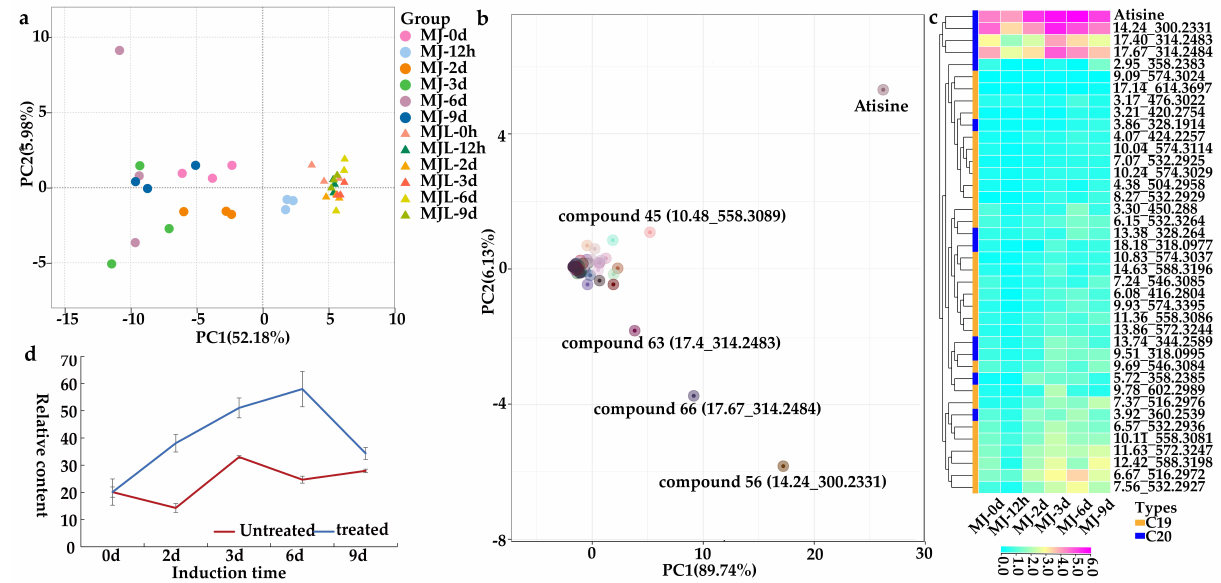
Figure 1. The production of Das is a major metabolic response of A. gymnandrum sterile seedlings to induction. MJ and MJL refer to the sample of root and aerial portions. ( a ) Principal component analysis of A. gymnandrum of different plant portions shows compounds with peak accumulation occurring at the indicated time, demonstrating that MJ has a greater impact on the root than aerial portions. ( b ) Principal component analysis of 77 metabolites in the root; the five compounds most representative of the first principal component are atisine, compound 45 , compound 56 , compound 63 , and compound 66 . ( c ) Cluster analysis of 40 metabolites in the root from A. gymnandrum at different induction times. The value of each compound was taken from relative content Log 2 standardization. ( d ) Plots to demonstrate the increasing accumulation of the atisine in the root (error bars represent the standard error). Untreated and treated refer to the control group and experimental group, respectively.